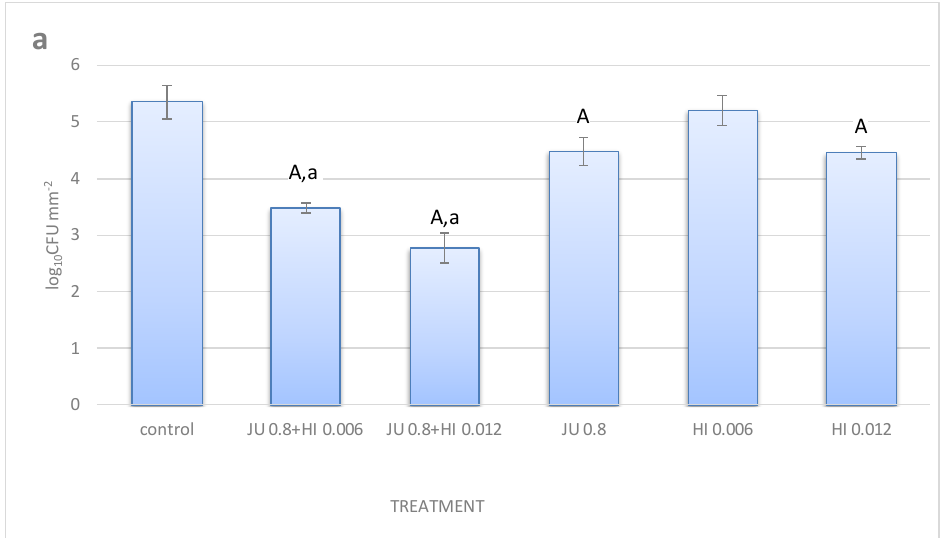
Figure 3. Effect of the MIC and 2 × MIC in mg mL −1 of J. communis and H. italicum EOs on the deg- radation of biofilms of M. avium ( a ), M. intracellulare ( b ), and M. gordonae ( c ) formed on stainless steel (AISI316) discs. Untreated mycobacterial cells served as controls. MIC—minimum inhibitory concentration; CFU—colony forming unit; JU— Juniperus communis ; HI— Helichrysum italicum . The experiment was repeated three times in duplicate and the mean ± SD is shown. Mean values marked with an uppercase letter A were significantly different compared to the control group. Mean values marked with lowercase letter a represent significant differences within different groups of EOs ( p < 0.05).